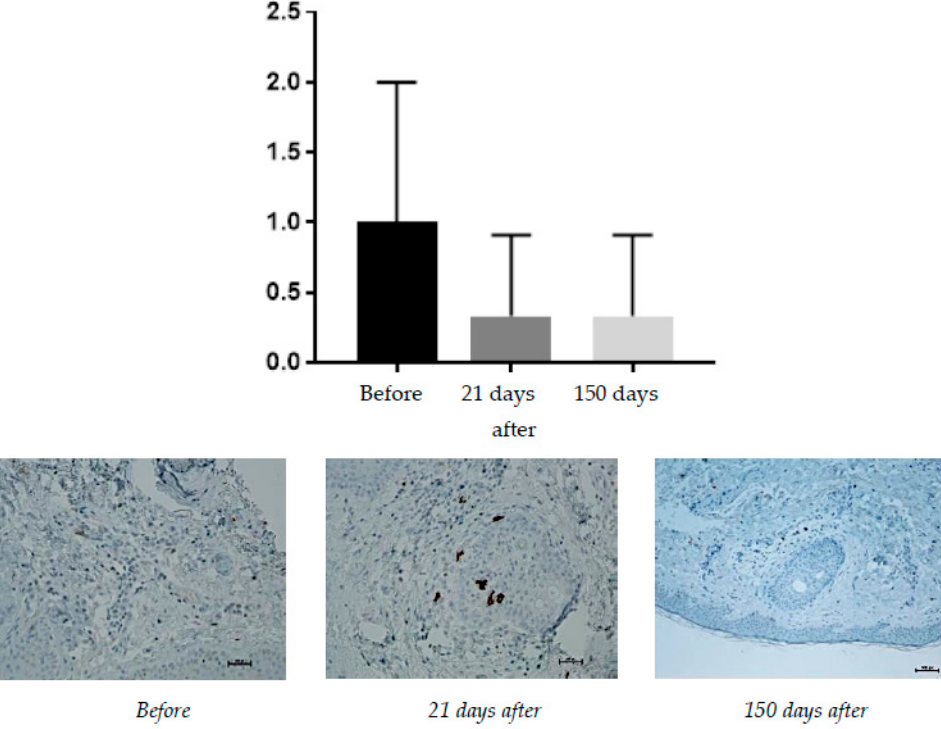
Figure 3. Patient, 60 years old. From left to right: before treatment; 21 days after treatment; 150 days after treatment. Protein expression was rated on a scale from 0–100% of inflammatory infiltrate cells (Figure 4).